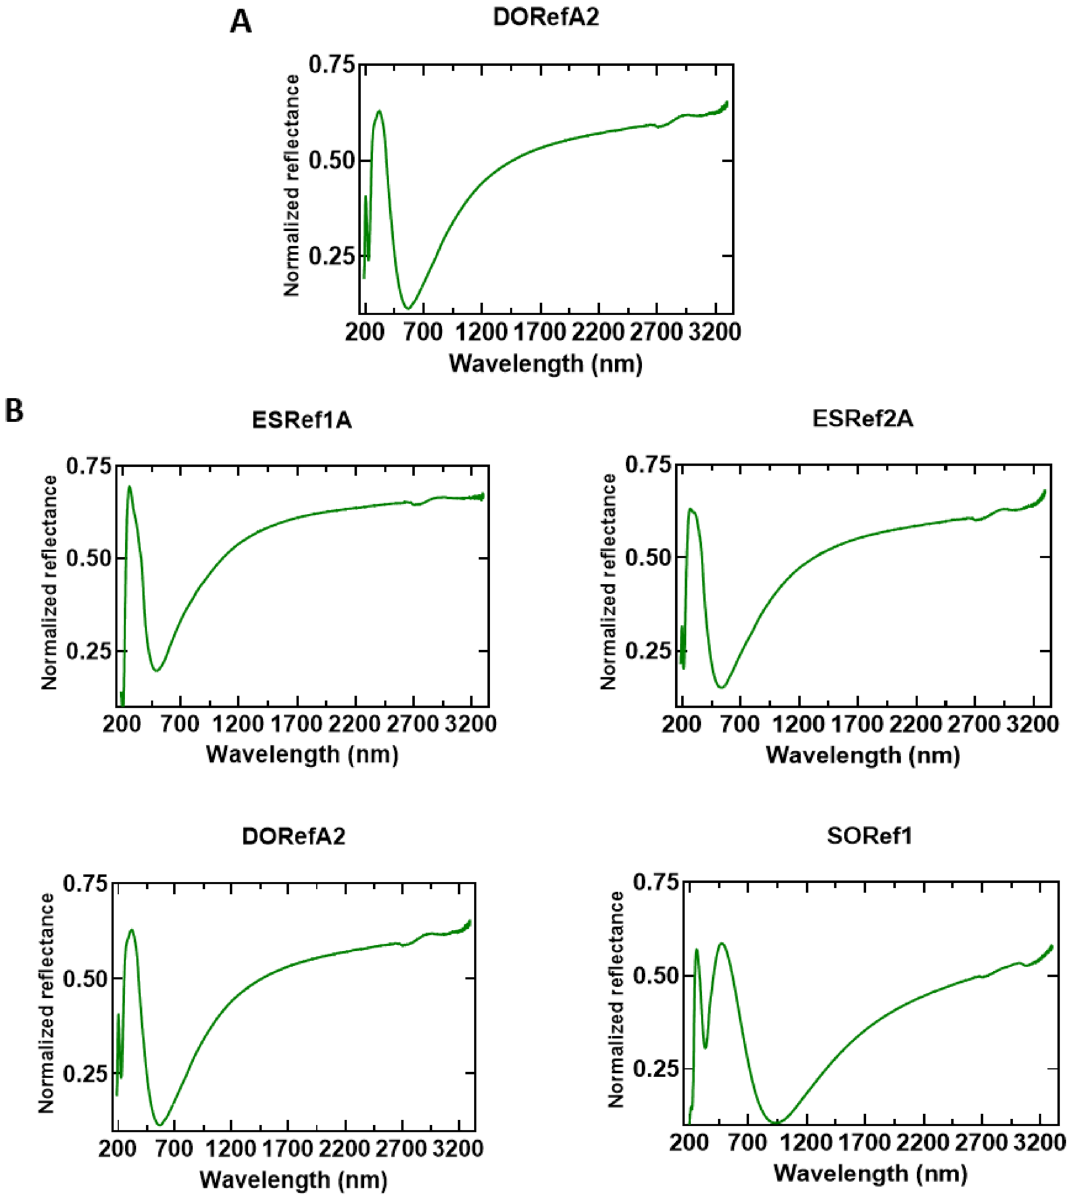
Figure 3. ( A ) UV–Vis–NIR reflectance spectra (200–3300 nm) of DORefA2 single-layer film fabricated by spin coating 1% w/w reflectin DORefA2 in HFIP onto clean Si wafers. ( B ) UV–Vis–NIR reflectance spectra (200–3300 nm) of other single-layer films fabricated under the same conditions. Angle of incidence: (Fig. 6B). Markedly, at 20°, while all spectral features of our single-layer films were maintained (Fig. 6C, left panel), increasing the angle of incidence now had little to no impact on reflectivity below 1500 nm (Fig. 6C, middle panel). As the angle of incidence increased from 20° to 70°, normalized reflectance intensity was mostly conserved and the visible peak at ~ 350–450 nm was retained as the peak reflectance in the visible region (Fig. 6C, right panel). As the SEM suggests that well-defined layers are not observed, we sought to investigate whether this unique optical response is the result of a single layer composed of a mixture of reflectin and BSA, or is due to some pseudo-multilayered structure that is reliant on our method of sequential coating. Controls fabricated using a DORefA2/BSA mixture and BSA alone (Fig. 7A–D respectively) still exhibited angle-dependent reflectiv- ity below 1500 nm, suggesting that both layer separation and composition, respectively, are significant factors that contribute to angle-independent visible reflectivity. However, further characterization, including precise determination of layer thickness, is required to confirm this suggestion. Interestingly, for our multilayer film, at wavelengths above 1500 nm we noted that the increase in reflectance intensity was amplified, with the same peak at around ~ 2370 nm emerging at 60°/70°, but to an even greater extent. To our knowledge, this is the first example of a reflectin-based film whose specular reflectance has been shown to be modulated with respect to viewing angle. Thus, combined with the dynamic capabilities of the current generation of reflectin-based materials, such